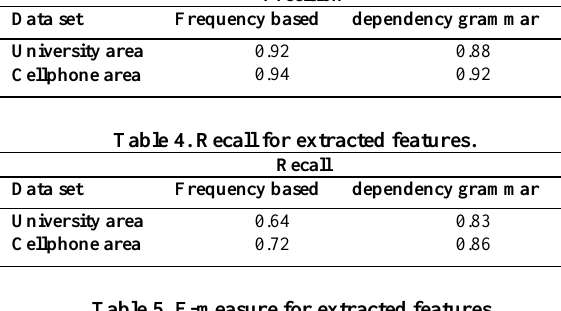
Table 3. Precision for extracted features.